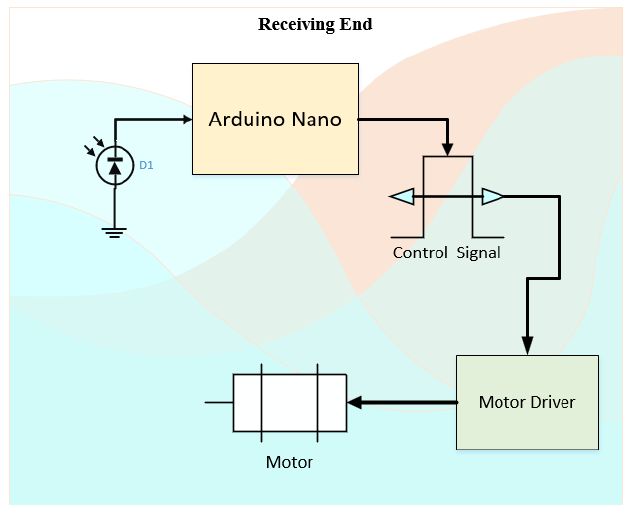
Figure 4. Proposed VLC tele-weight receiving